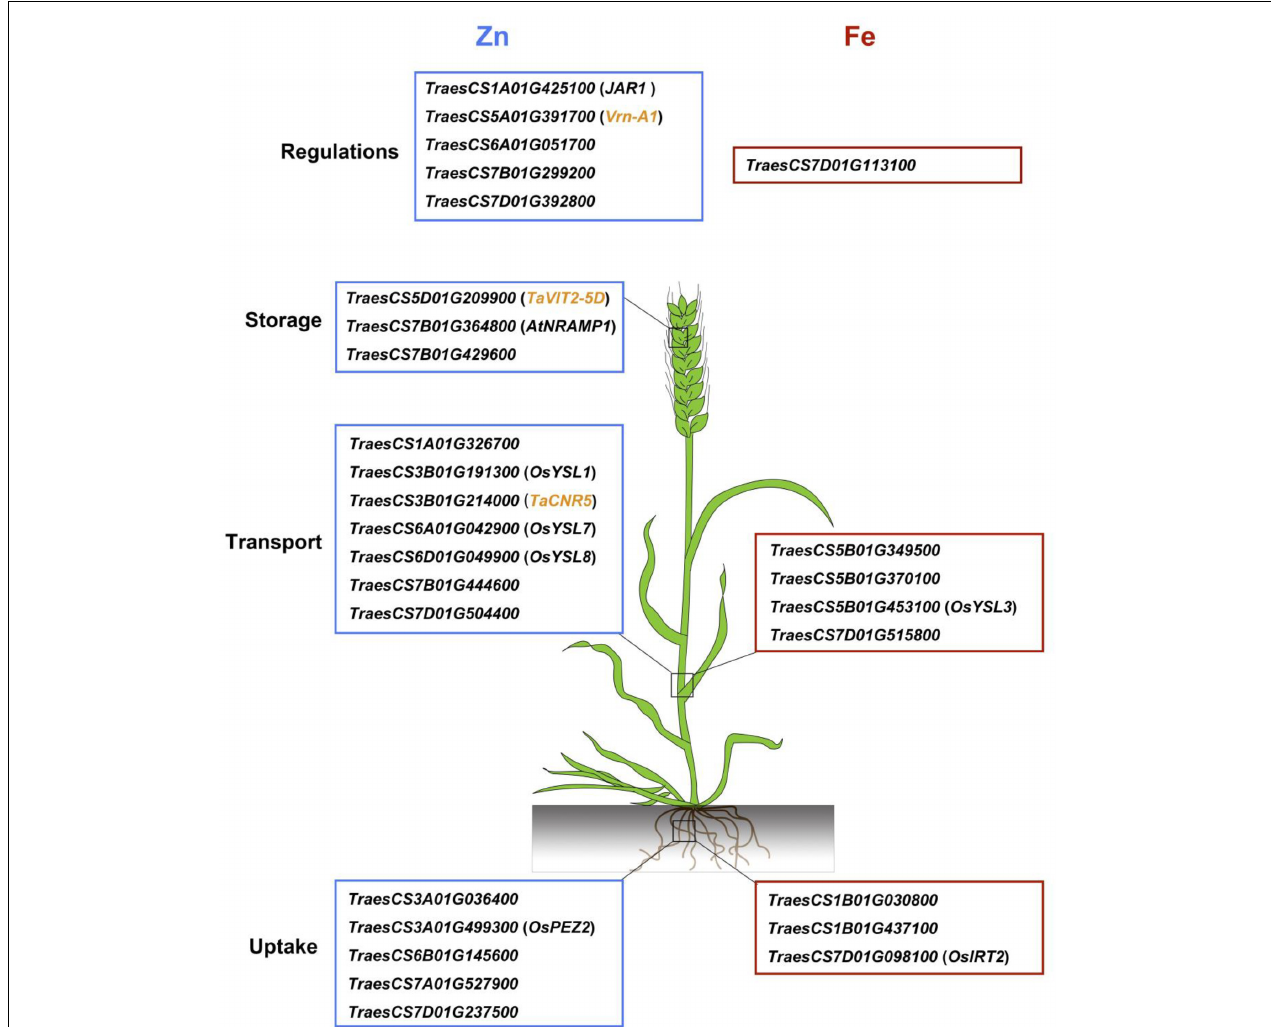
FIGURE 4 | A brief model proposed for grain zinc and iron accumulation in common wheat based on the promising candidate genes identified. The wheat gene ID framed with blue and red boxes indicates zinc and iron genes, respectively, and the genes in the small brackets indicate known Zn/Fe related genes in model plants. The cloned zinc related genes in wheat are highlighted as